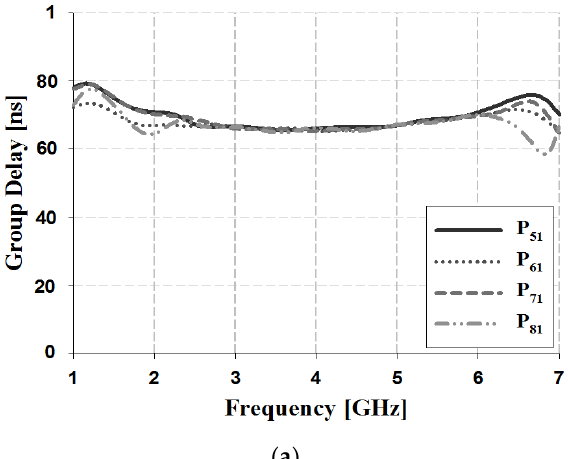
Figure 21. Measurement analysis of phase difference for input Port 2. Table 3. Measurement results of phase difference for 4 × 4 Butler matrix.